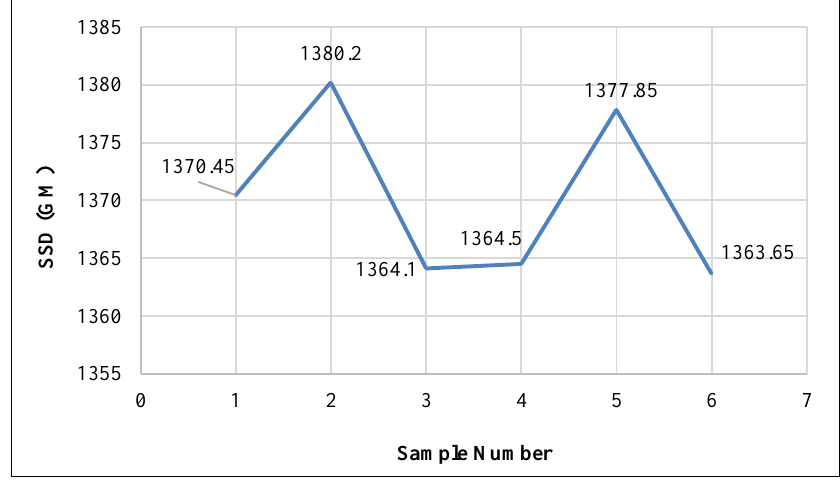
Figure 23. Saturated surface dry (SSD) values for six batches